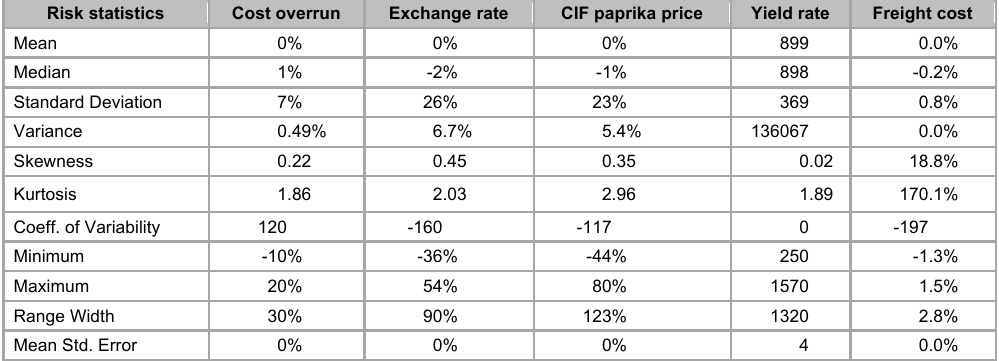
Statistics of custom distributions for risk